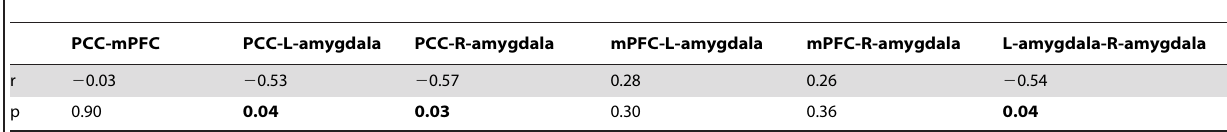
Table 2. Pearson’s correlations between the PCC, mPFC, left amygdala, right amygdala and CAPS in PTSD patients.